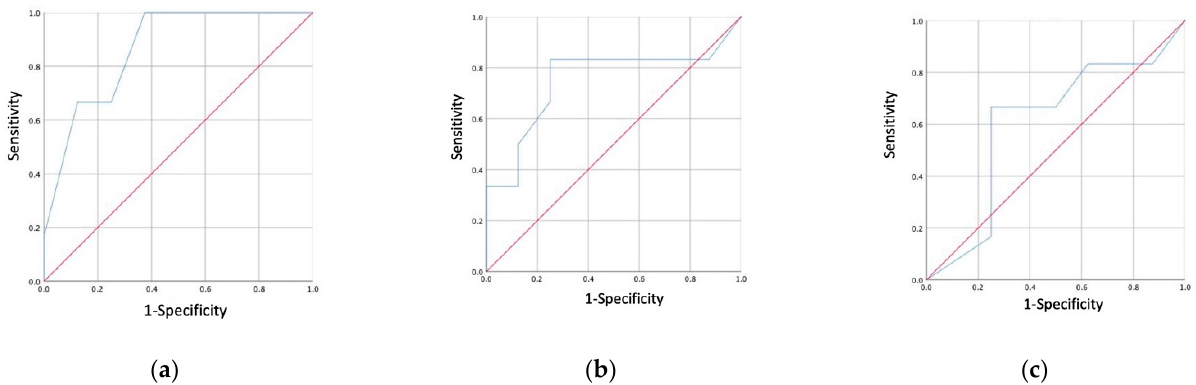
Figure 7. ( a ) The ROC curve of FMA measurement (between anterior teeth extrusion and molar intrusion); ( b ) the ROC curve of upper molar height measurement (between anterior teeth extrusion and molar intrusion); ( c ) the ROC curve of upper incisor height measurement (between anterior teeth extrusion and molar intrusion).